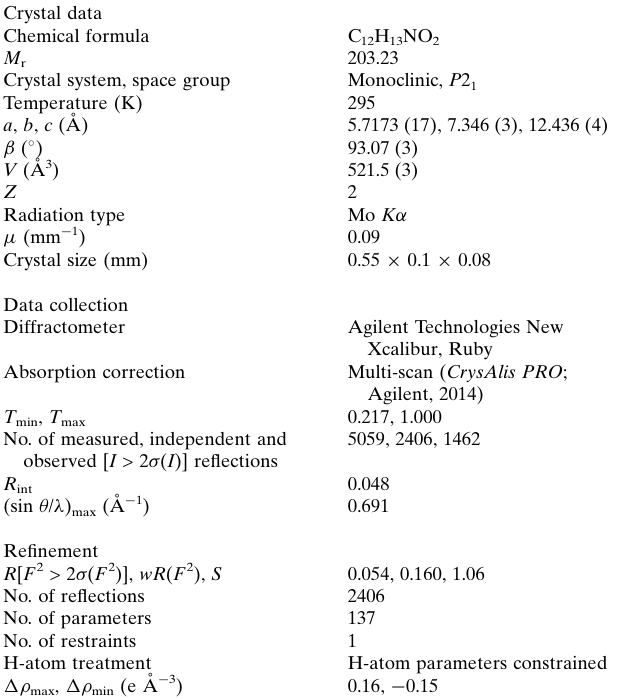
Table 2 Experimental details.